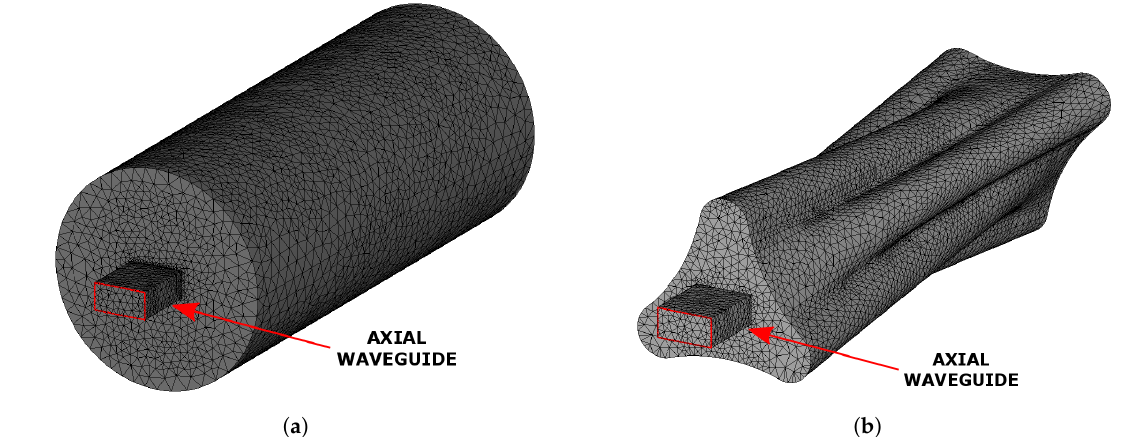
Figure 2. ( a ) Standard cylindrical cavity and ( b ) “plasma-shaped” cavity models. Applied mesh and axial feeding waveguides are visible.